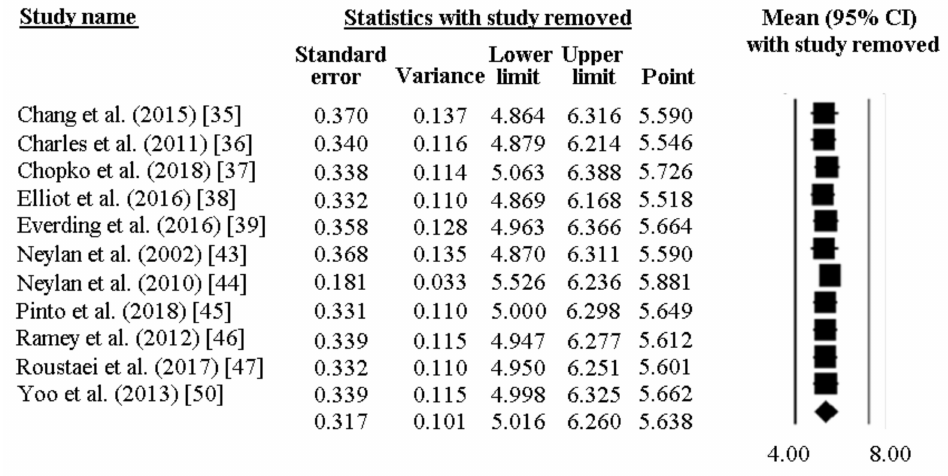
Figure 7. Sensitivity analysis for the pooled PSQI global score in police officers, showing stability and reliability of the findings.